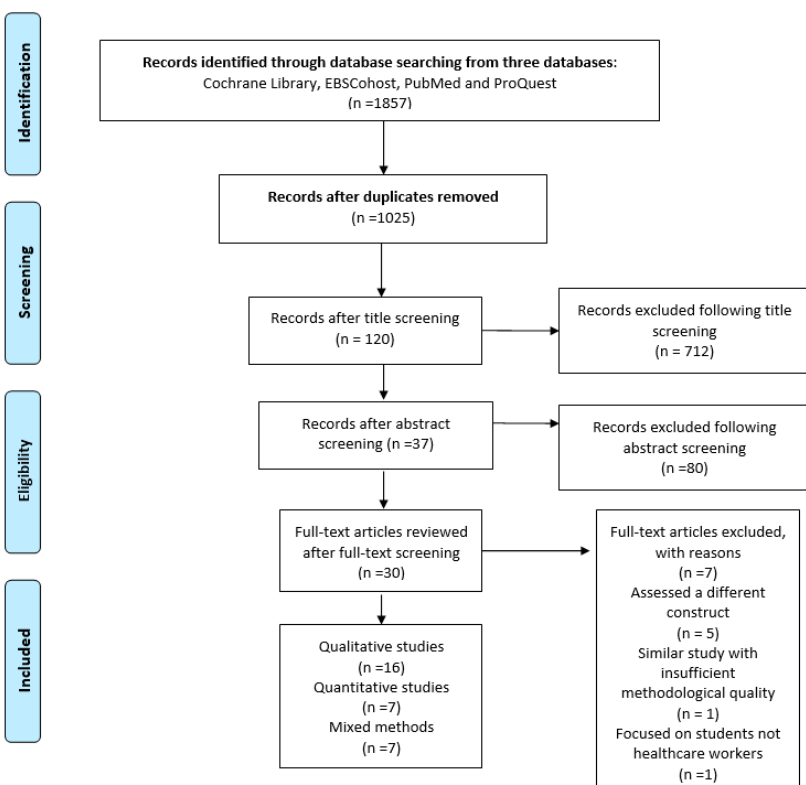
Figure 1. The Preferred Reporting Items for Systematic Review and Meta-Analyses (PRISMA) flow diagram on healthcare workers’ determinants of motivation in the East African Community (EAC), 2009–2019.